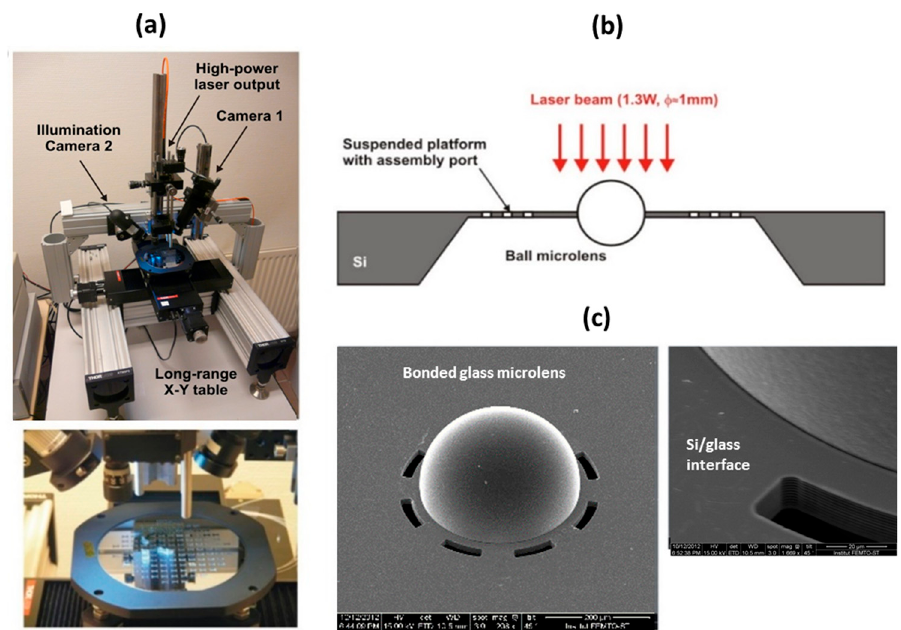
Figure 17. Laser-assisted bonding of glass ball microlens with silicon membrane: ( a ) high-power laser bonding station; ( b ) schematic drawing of the process; and, ( c ) SEM micrograph of bonded glass microlens.